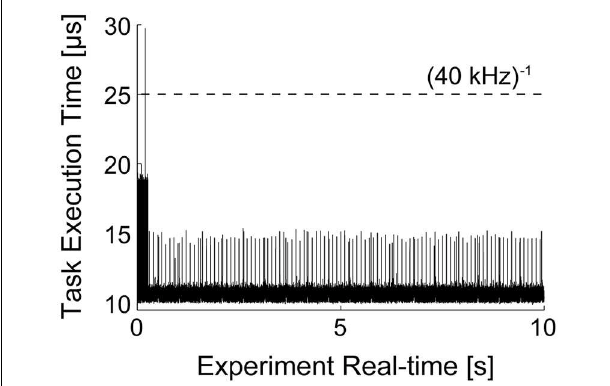
FIGURE 6 | Task execution time (TET) of model presented in Figure 5. The MATLAB/Simulink-xPC combination allows the monitoring of performance of the target PC, while executing the specified model. This makes possible to assess whether the computational loads, imposed e.g., by the recreated in vivo -like background synaptic activity and by the PID automatic regulation of the neuronal firing frequency, are compatible with the model operation in real-time. The initial overhead and the periodic peaks are a consequence of the firing-rate (see Section Clamping the Neuronal Firing Rate and Figure 7 ) and of transient loads of non-optimized routines. Nonetheless, the model could be run at sampling frequencies higher than 50kHz.